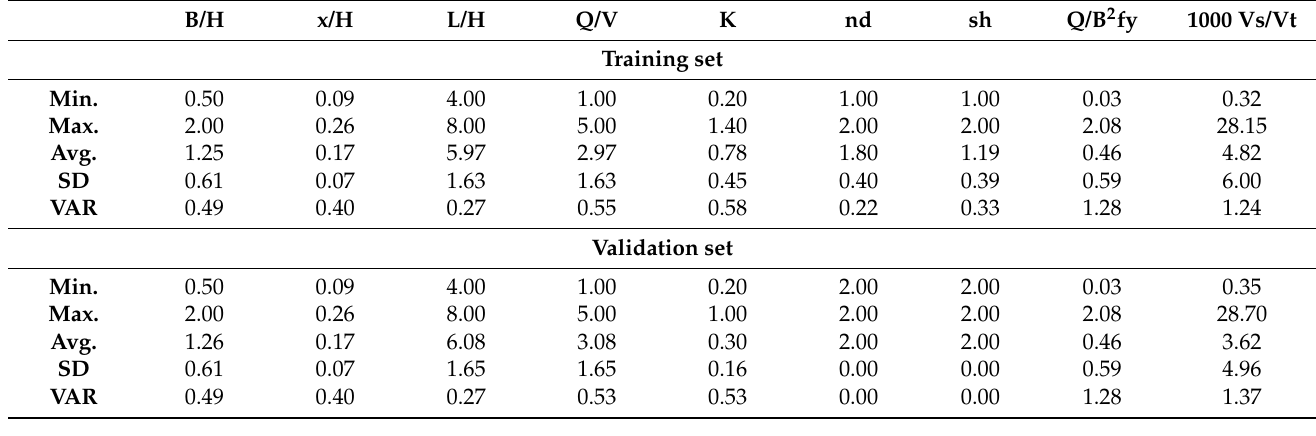
Table 3. Statistical proprieties of database parameters.